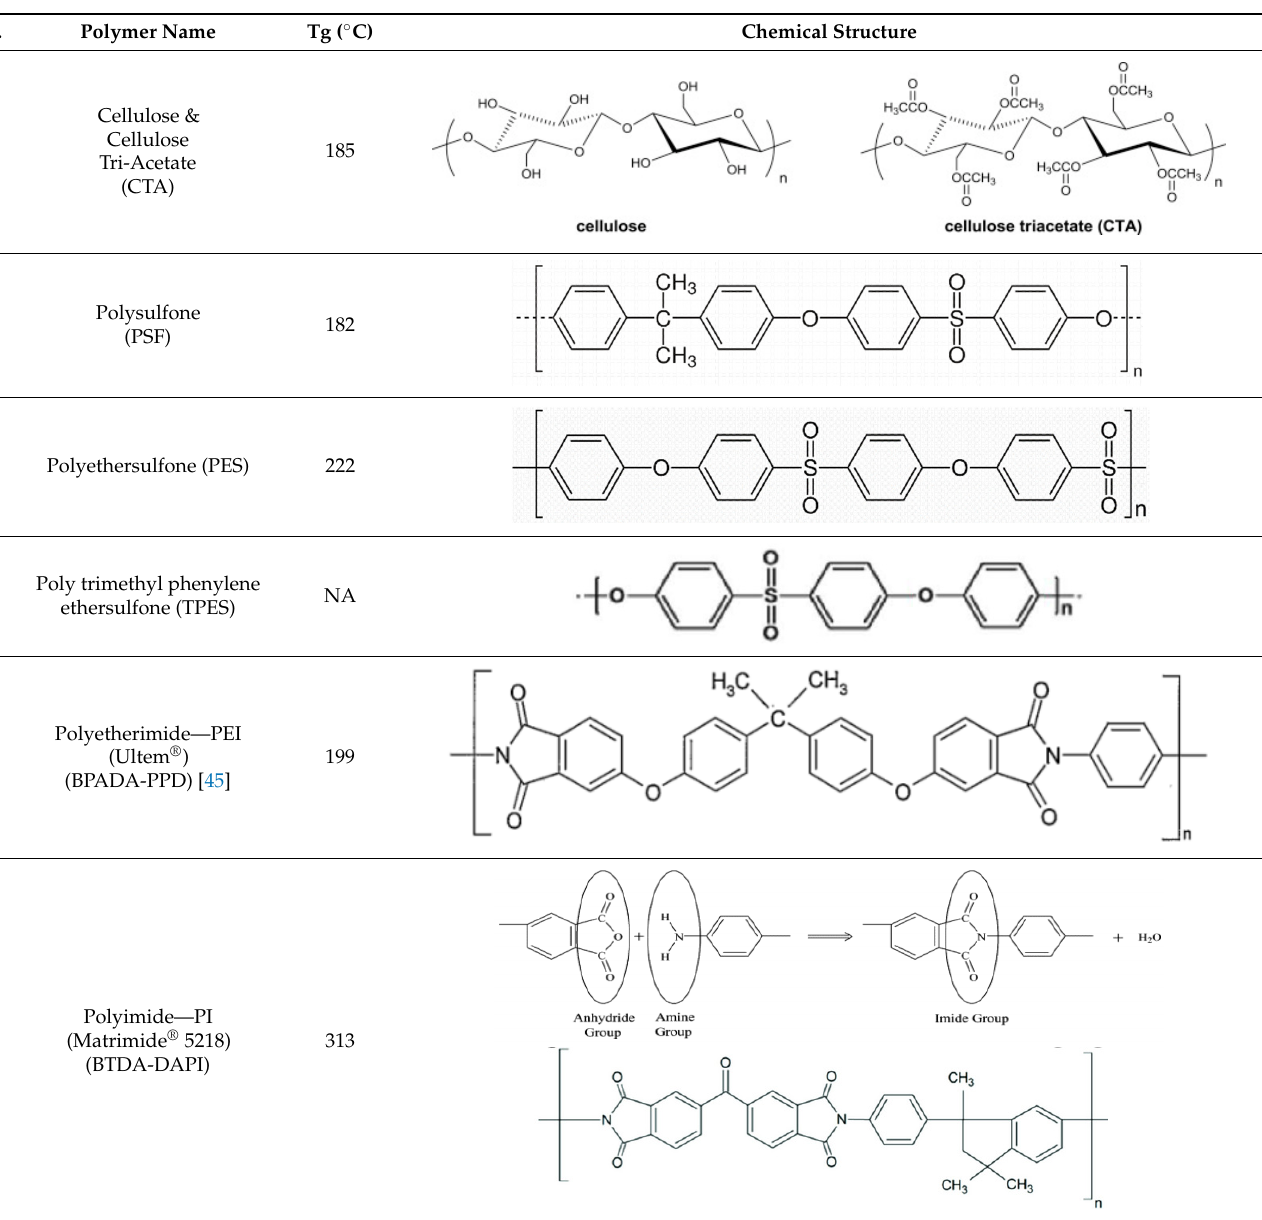
Table 2. Chemical structure and Tg for various polymers.